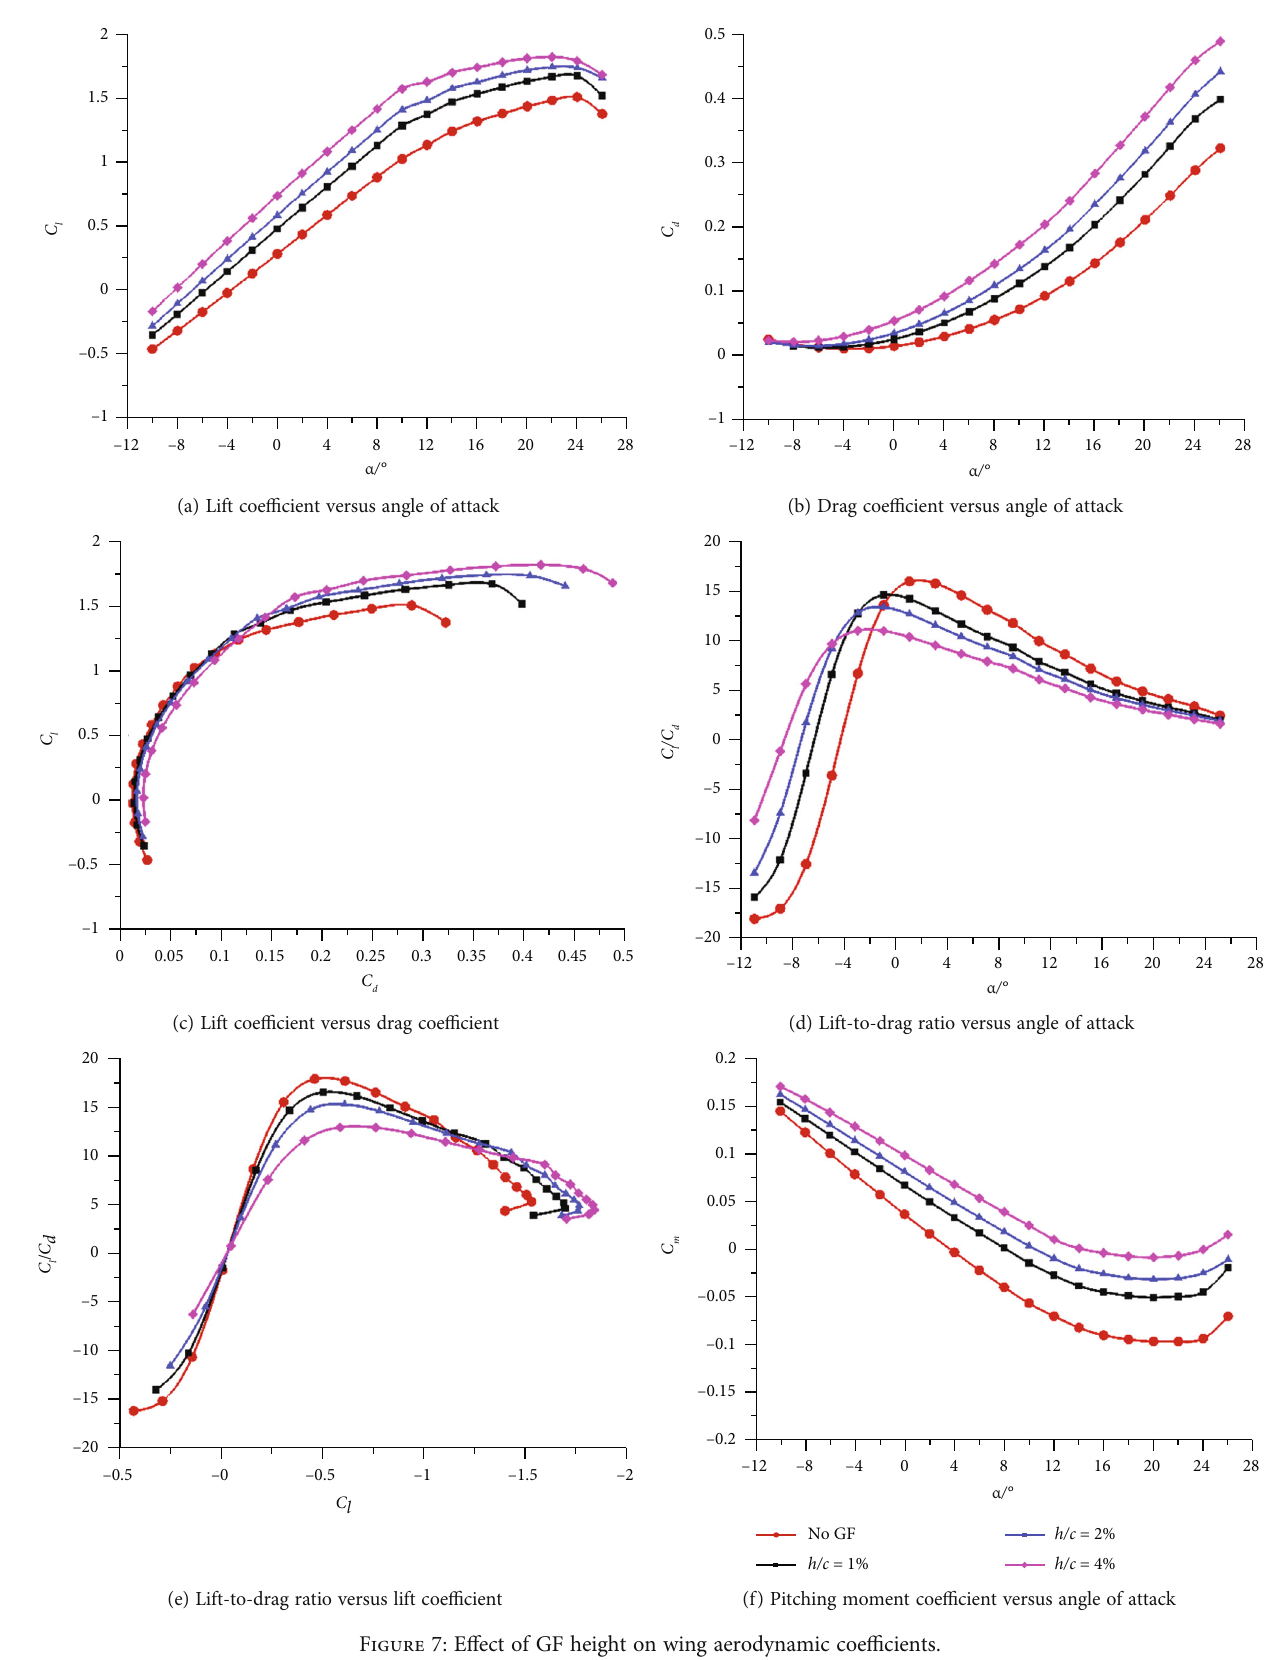
Figure 7: E ff ect of GF height on wing aerodynamic coe ffi